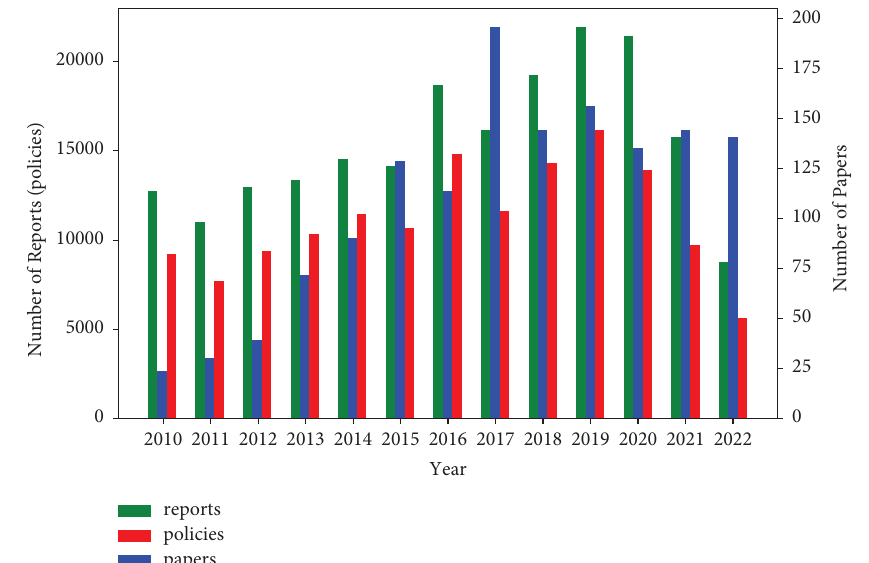
Figure 5: Te data are arranged by year, showing the number of texts consisting of reports, policies, and papers for each